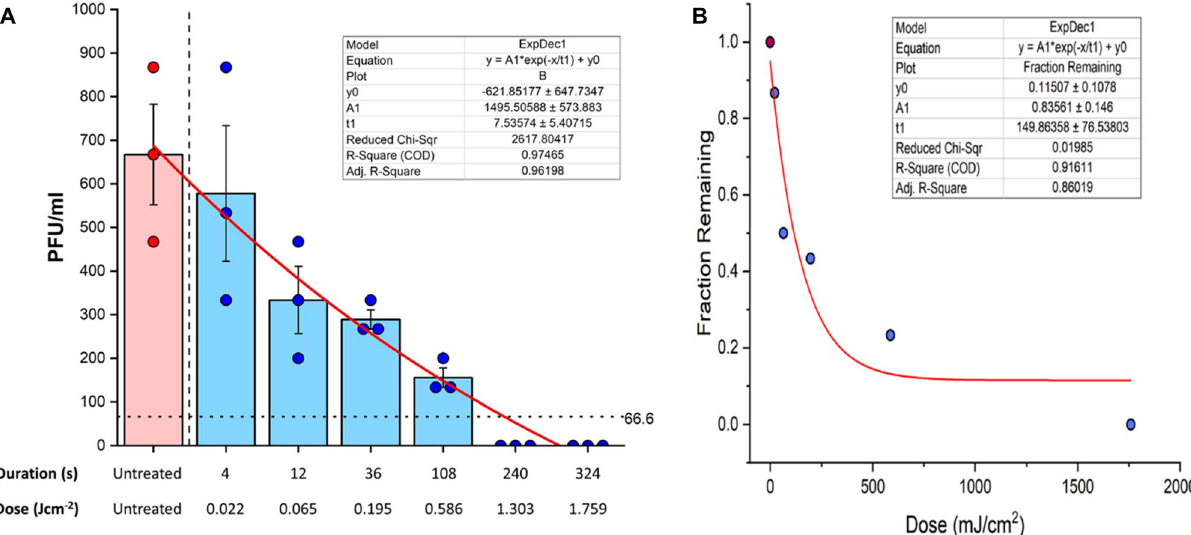
Figure 4. UVC irradiation for 240 s inactivates over 2.5 log reduction in EMCV viral titers. ( A ) Time course log reduction of EMCV PFU in N95 test coupons treated with UVC irradiation. N95 mask squares (2.5 cm 2 ) with all layers were incubated with infection media spiked with EMCV for 15 min. The mask coupons were then placed on open 10 cm polystyrene cell culture dishes 15.2 cm from the lamp. After warming up the lamp, the coupons were treated for the indicated amount of time per each side, and were left in infection media at 4 °C overnight. One ml of the respirator derived media mix was used from each condition and was titered in VERO-CCL81 cells using standard plaque assays and crystal-violet staining. Each dot represents data from three independent experiments and plotted data bars represent mean and standard deviation for the triplicates. Vertical dashed line delineates untreated and treated parts of the experiment. Horizontal dotted line indicates the minimal level of detection (approximately 67 PFU ml −1 ). Baseline for the assay is shown using a continuous line. ( B ) Regression analysis of viral reduction as per timely UVC